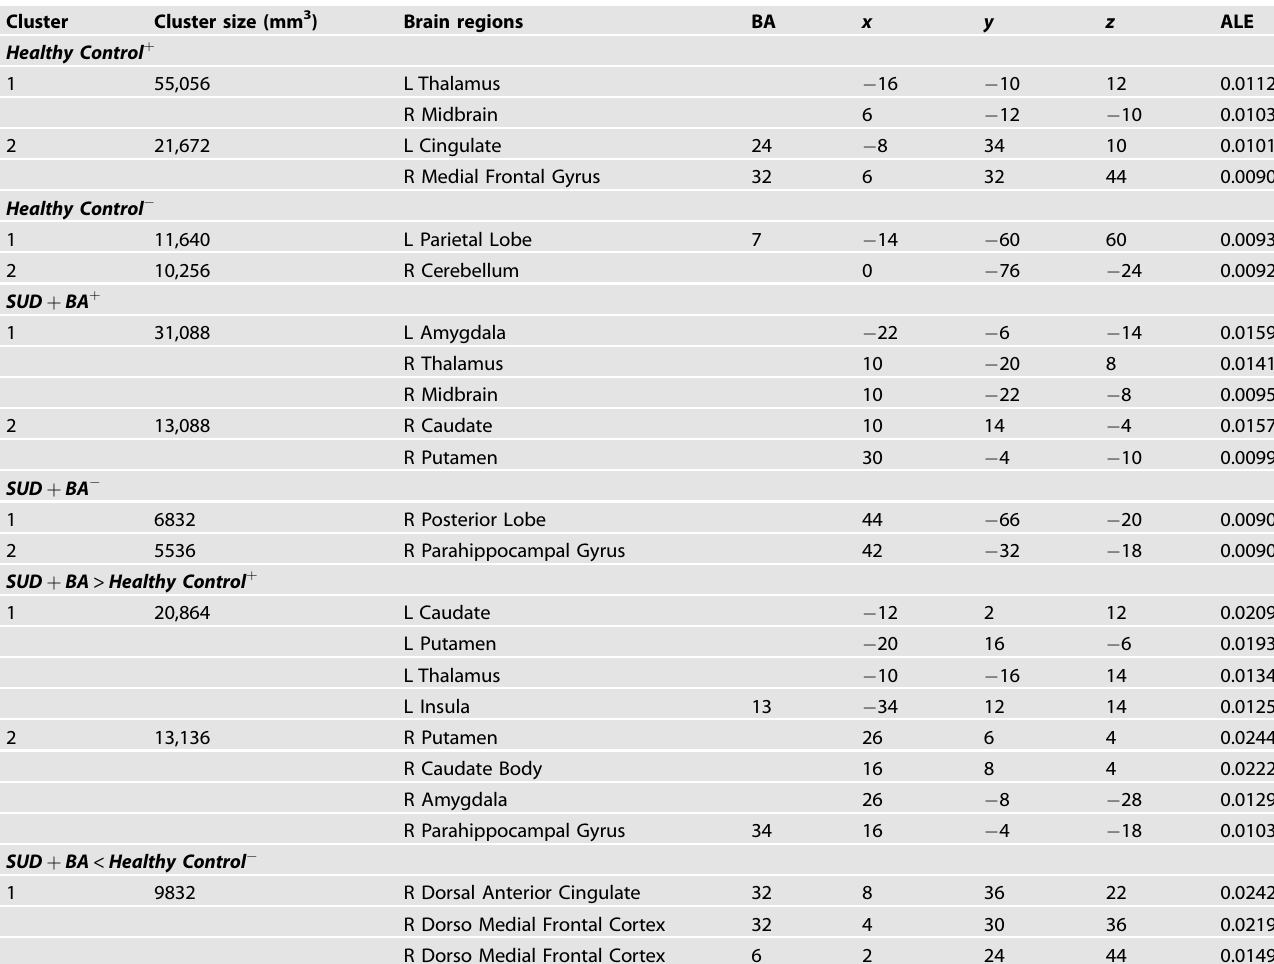
Table 3. Results of the meta-analysis of resting-state functional connectivity in SUD + BA and controls. Cluster